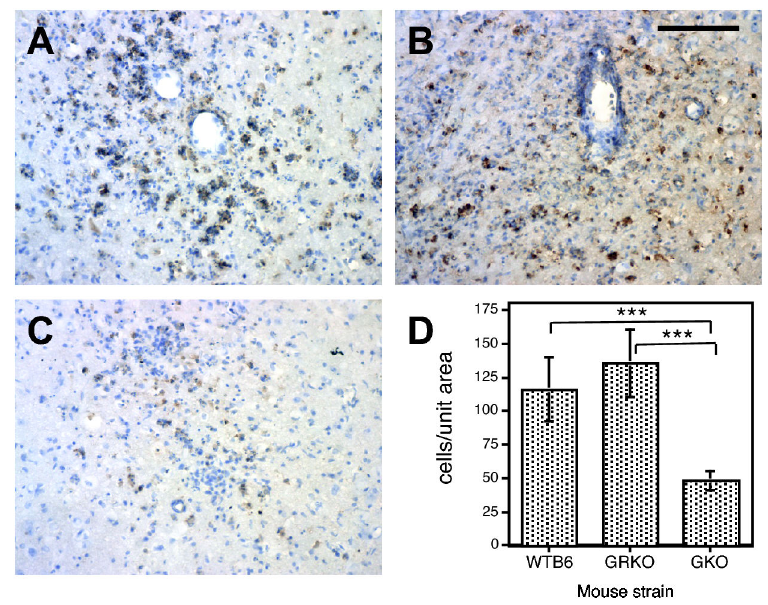
Figure 6. Immunohistochemical staining for MHC class I. Frozen sections from the thalamus of WTB6 (A), GRKO (B) and GKO (C) mice were stained with mouse monoclonal anti-H-2K b /H-2D d for identification of MHC class I antigen-positive cells 7 days after intranasal infection with 10 5 pfu NSV. Representative sections are shown. X250. Scale bar = 100 um. (D) Quantification of MHC class I-positive cells/0.16 mm 2 (unit area) in thalamus tissue from 2 mice in each group. Photomicrographs of 5-7 areas were taken (250X magnification) and numbers of stained cells were counted. Each bar indicates the mean +/- SEM. *** P < 0.001; t test.